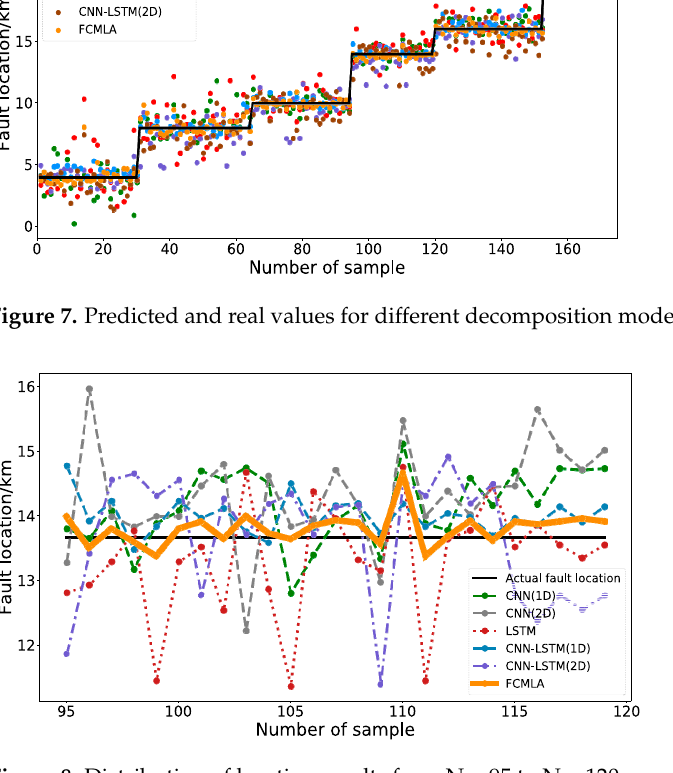
Figure 8. Distribution of location results from No. 95 to No. 120.